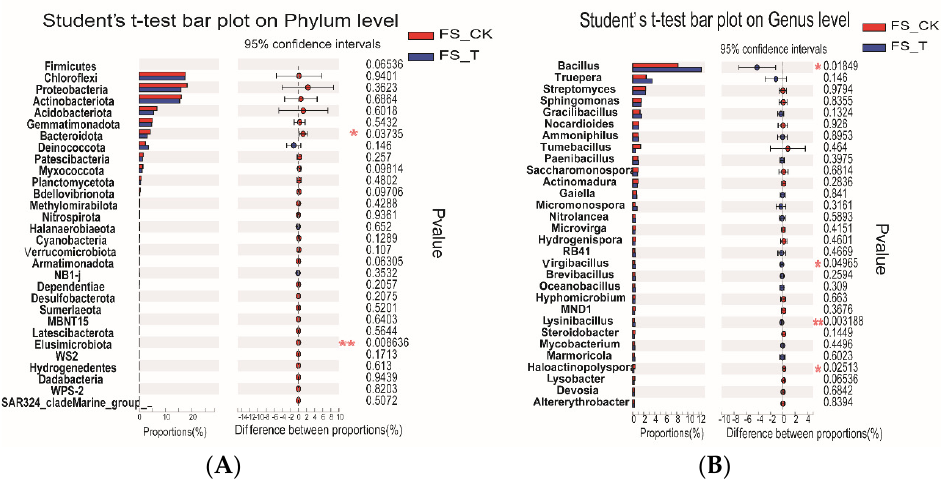
Figure 6. Changes in the relative abundance of bacterial ( A ) phyla and ( B ) genera in triple-fumigated soil that had been used to produce tomatoes. ‘Triple fumigation’ refers to the simultaneous application of chloropicrin, dimethyl disulfide and metham sodium. The t -test reported the statistical differences (asterisked, * 0.01 < p ≤ 0.05; ** 0.001 < p ≤ 0.01) between the means of three replicates within the phylum or genus levels.